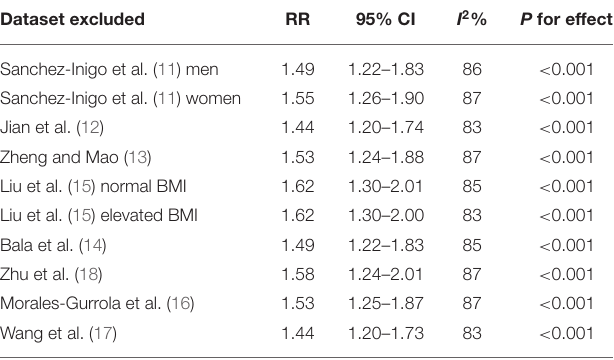
TABLE 2 | Results of sensitivity analysis. TABLE 3 | Impact of study characteristics on the association between TyG index and odds of hypertension: univariate meta-regression